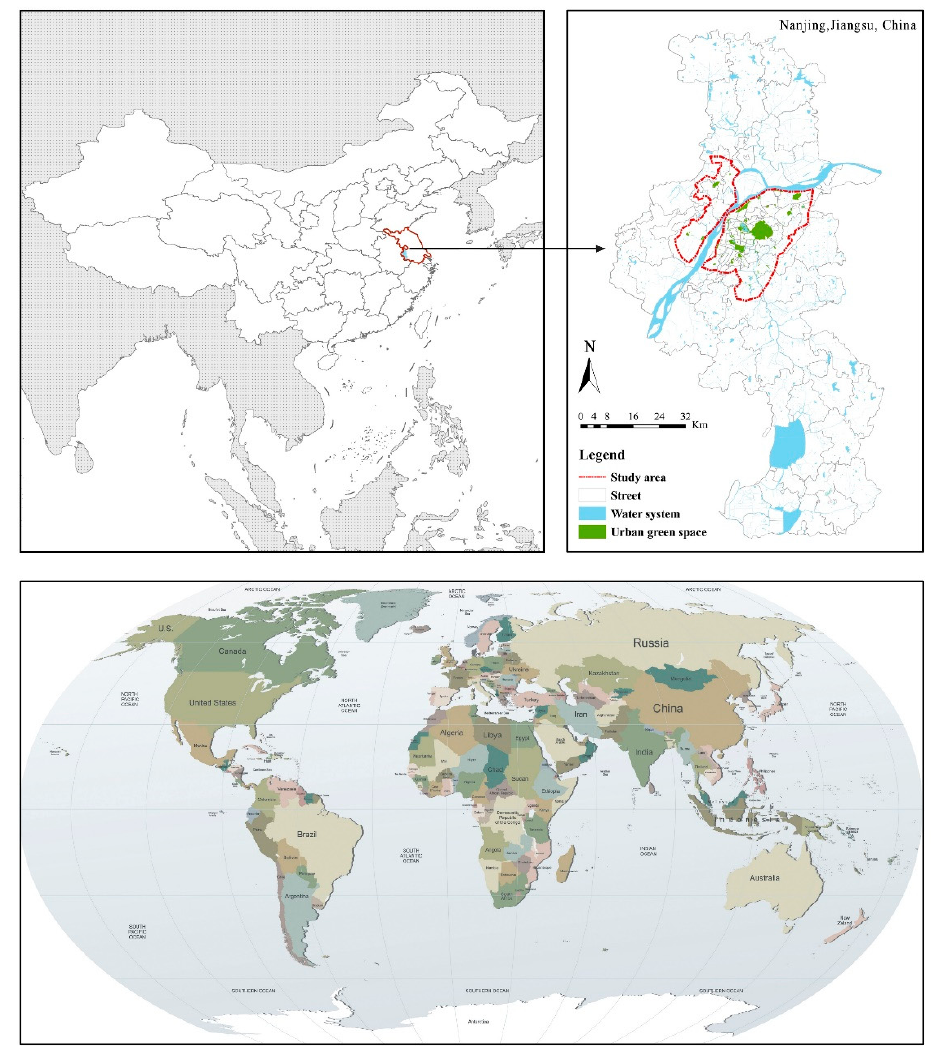
Figure 1. Location of central Nanjing, China. Table 1. Socioeconomic activities data